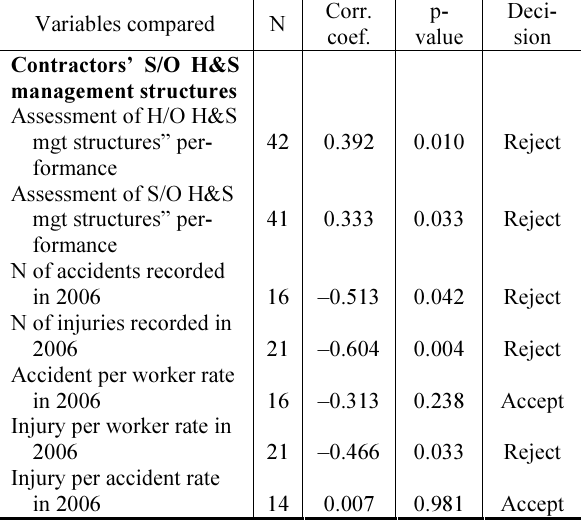
Table 5. Results of Spearman correlation between